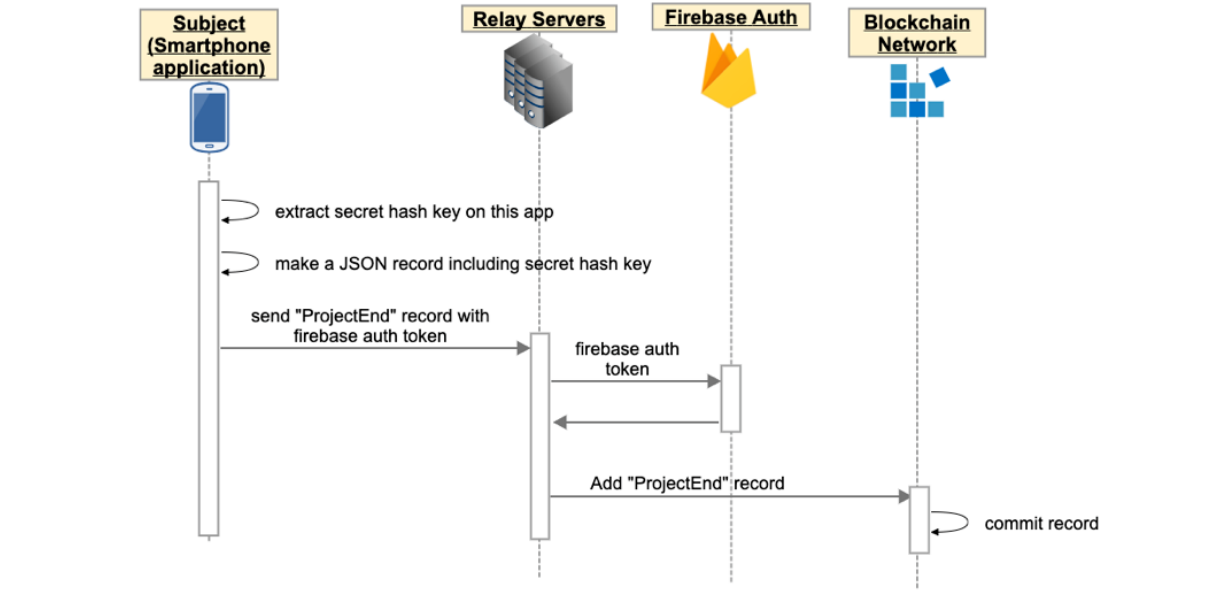
Figure 4. At the end of the clinical trial, the app extracts the secret hash key from the smartphone and sends it to the blockchain network via relay